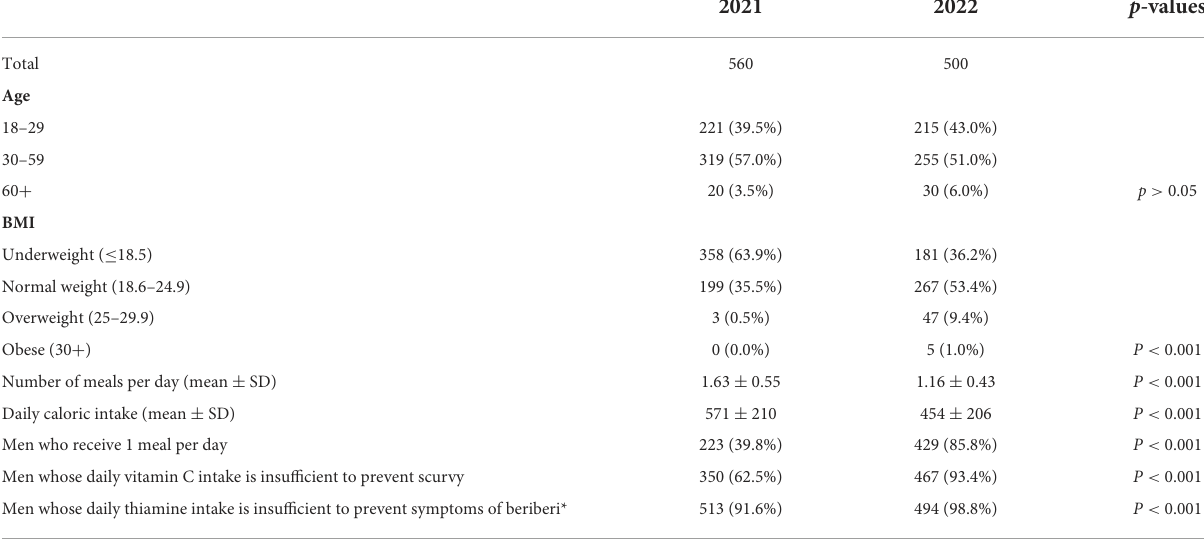
TABLE 1 Comparison of baseline and follow-up nutritional assessments combined for both